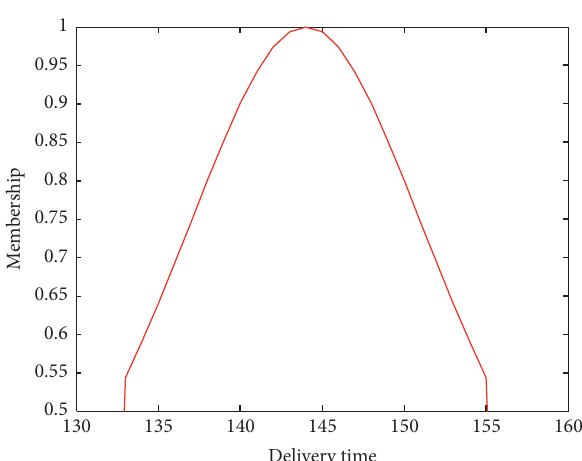
Figure 9: 􏽥 B ’s membership function.